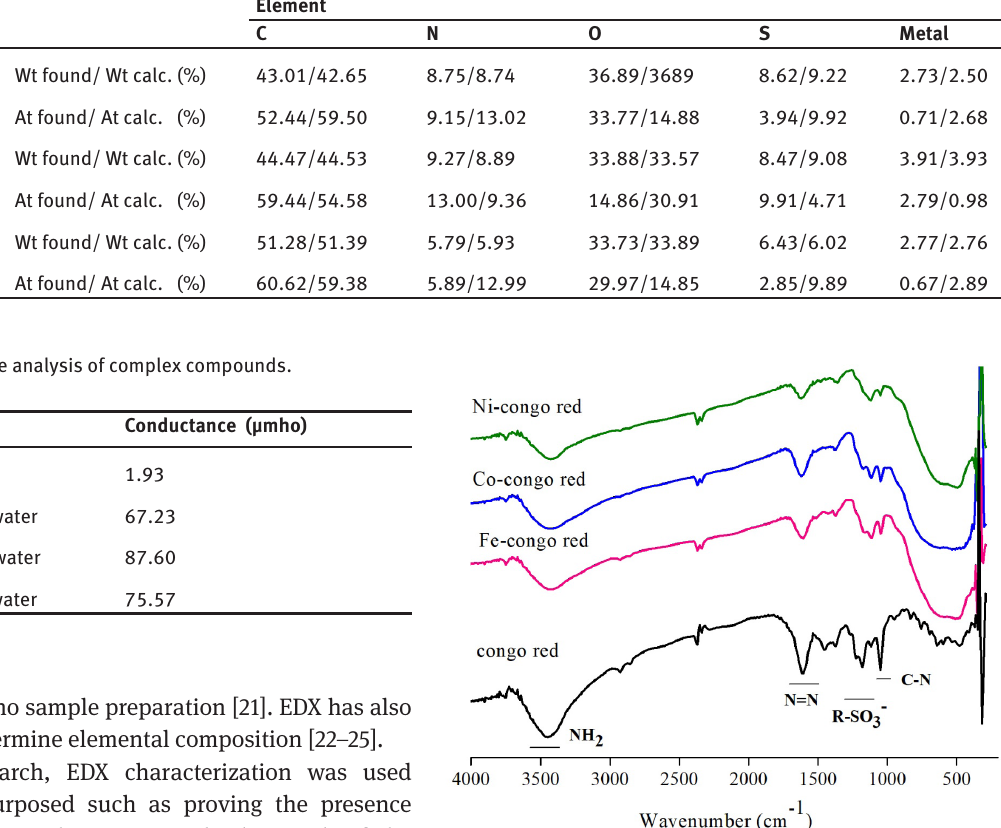
Table 2: The result of elemental analysis of congo red complexes. Compound Element